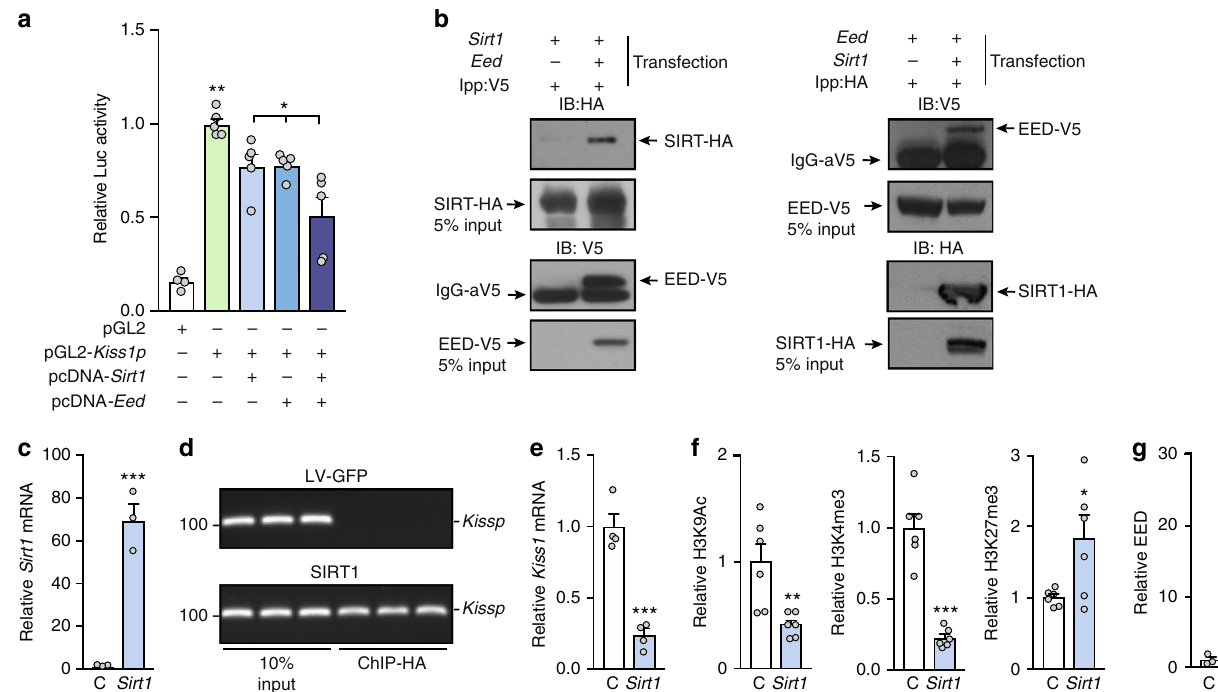
Fig. 8 Kiss1 expression is repressed by an SIRT1-EED silencing complex. a SIRT1 and EED repress KISS1 promoter activity as measured by gene reporter assays performed in Neuro2A cells. The bar histograms represent the mean ± SEM. * p < 0.05; ** p < 0.01 (one-way ANOVA followed by the Student − Newman − Keuls; n = 4 biological replicates per group). b SIRT1 and EED coimmunoprecipitate as determined in 293T cells transfected with SIRT1-HA and EED-V5 expression vectors; reciprocal pull-down assays are shown. c Sirt1 mRNA in rat hypothalamic R22 cells infected with a control (C) lentiviral construct expressing green fl uorescent protein (LV-GFP) or SIRT1. d CHIP assay showing association of SIRT1-HA to the Kiss1 promoter. e Kiss1 mRNA in C and SIRT1 overexpressing hypothalamic R22 cells. f Detection of H3K9Ac, H3K4me3 and H3K27me3 in C or SIRT1 overexpressing R22 cells. g Recruitment of EED to the Kiss1 promoter in C and SIRT1 overexpressing R22 cells. The bar histograms represent the mean ± SEM. * p < 0.05; ** p < 0.01; *** p < 0.001 vs. C group (two-sided Student ’ s t test; n = 4 per